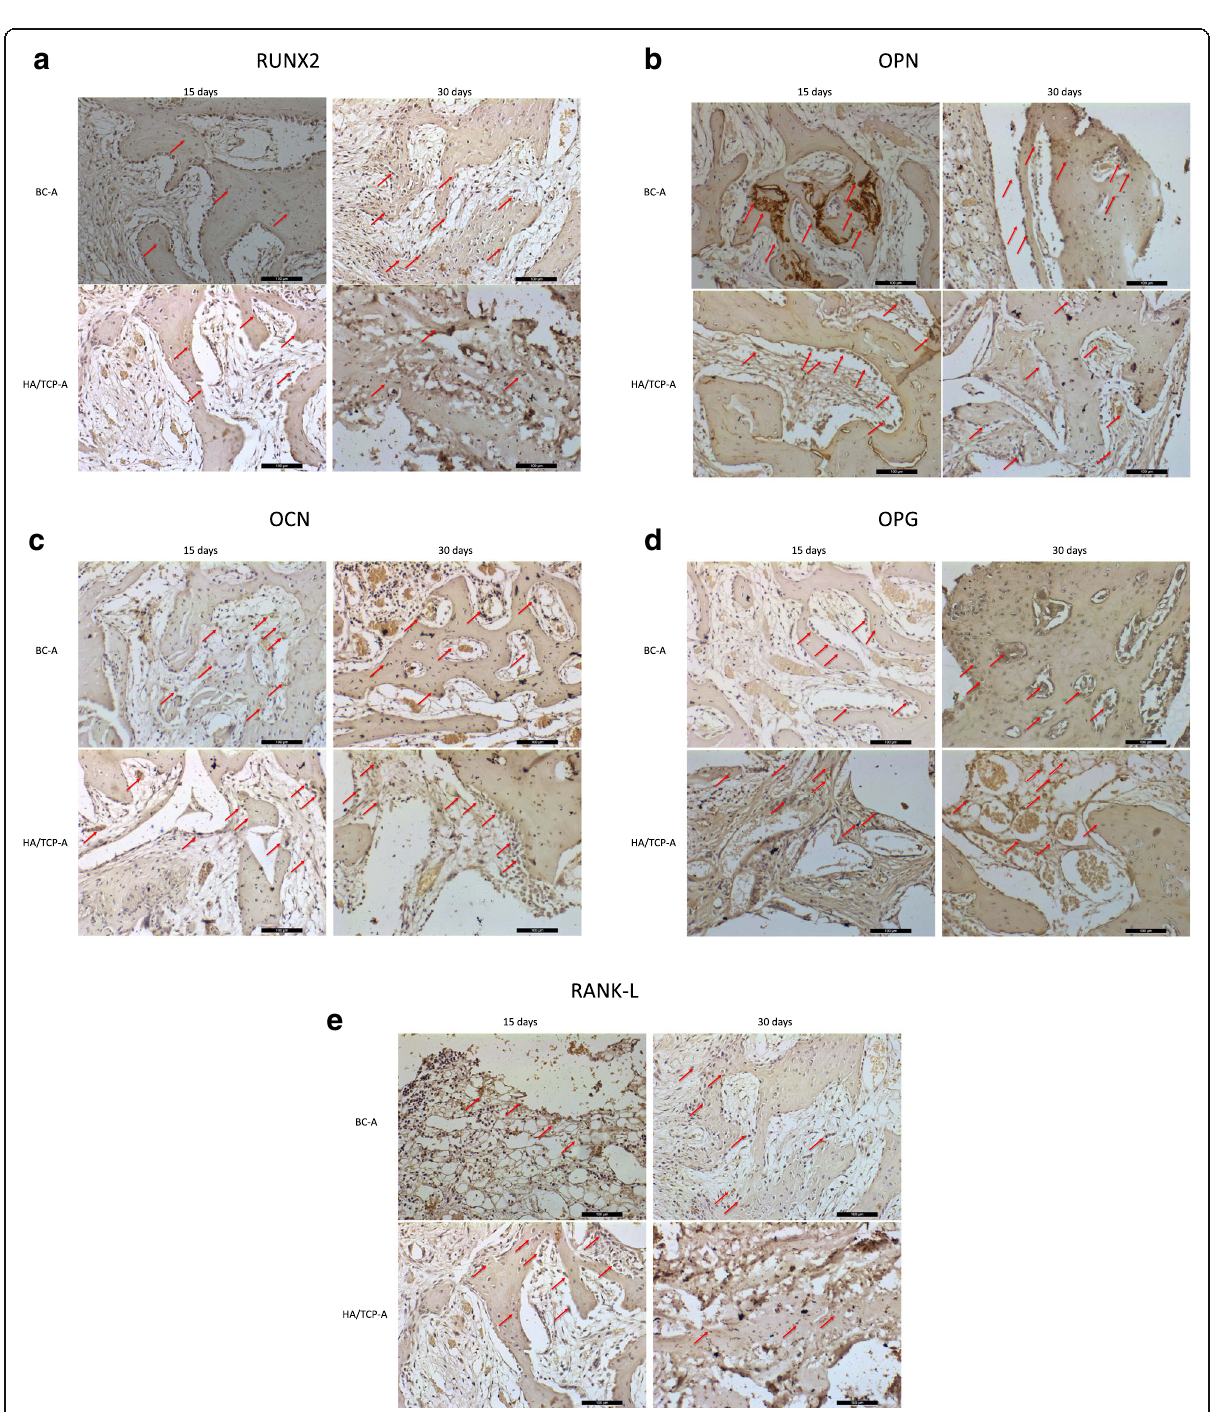
Fig. 7 Labeled samples for all antibodies according to porous-hydrophilic surfaces groups at both periods ( a – e ). Immunolabeling of proteins (red